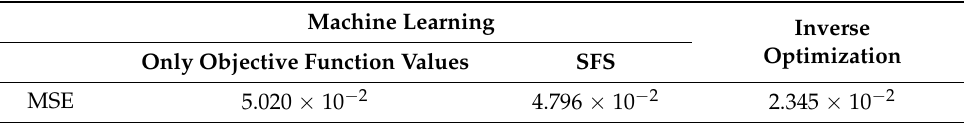
Table 13. MSE results of machine learning and inverse